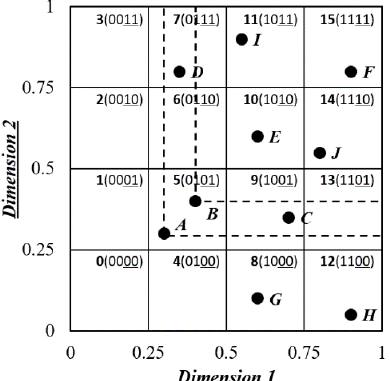
Figure 2. The partition results and the GLAD assigned to each partition.